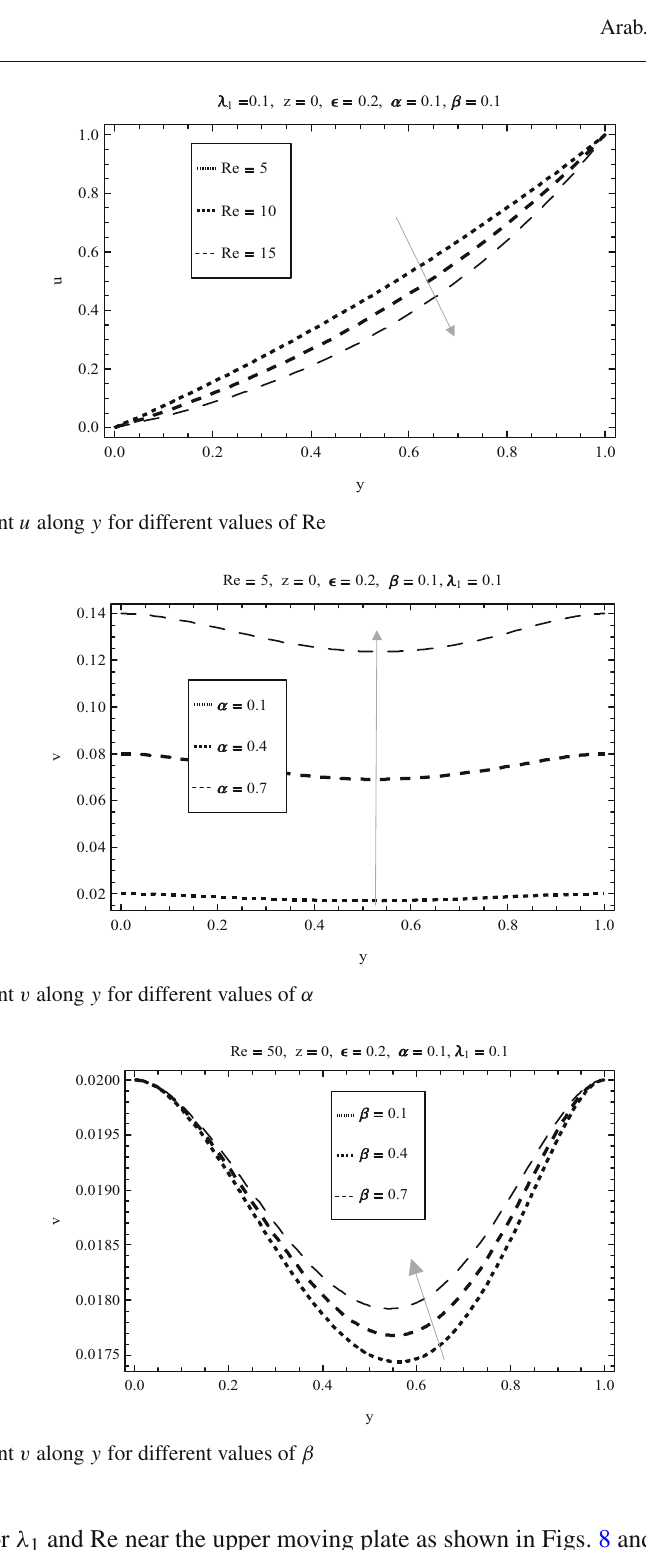
as a linear function for λ 1 and Re near the upper moving plate as shown in Figs. 8 and 9. Symmetric velocity profiles about the mid of the plates are